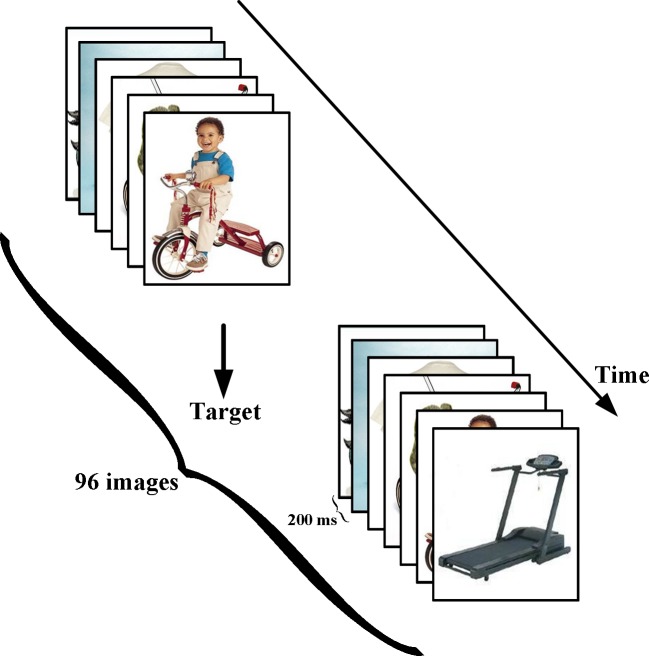
Rapid serial visual presentation (RSVP) paradigm.The RSVP sequence consisted of 25 blocks (a total of 2400 images, i.e., 25 target categories with 300 images and 175 nontarget categories with 2100 images), and each block comprised one target category (12 images) and seven nontarget categories (84 images). The images are presented in 25 blocks, with a distinct target category in each block. The target categories of each block are shown in Table 1. Each image is presented for 200 ms (The image is similar but not identical to the original image, and is therefore for illustrative purposes only).